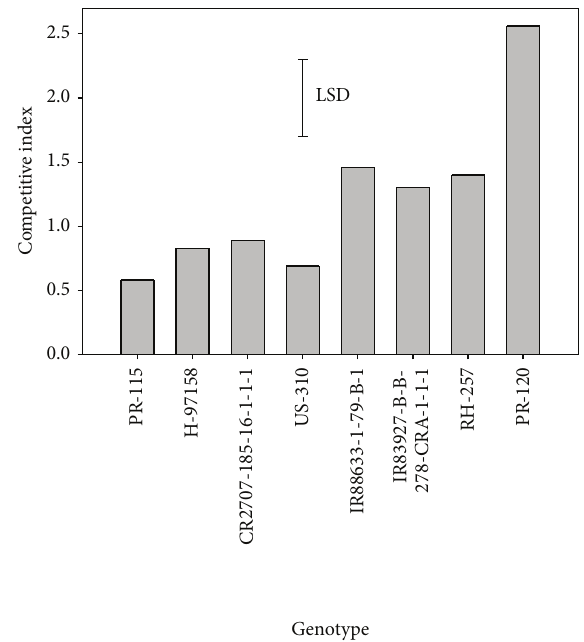
Figure 1: Weed competitive index of different rice